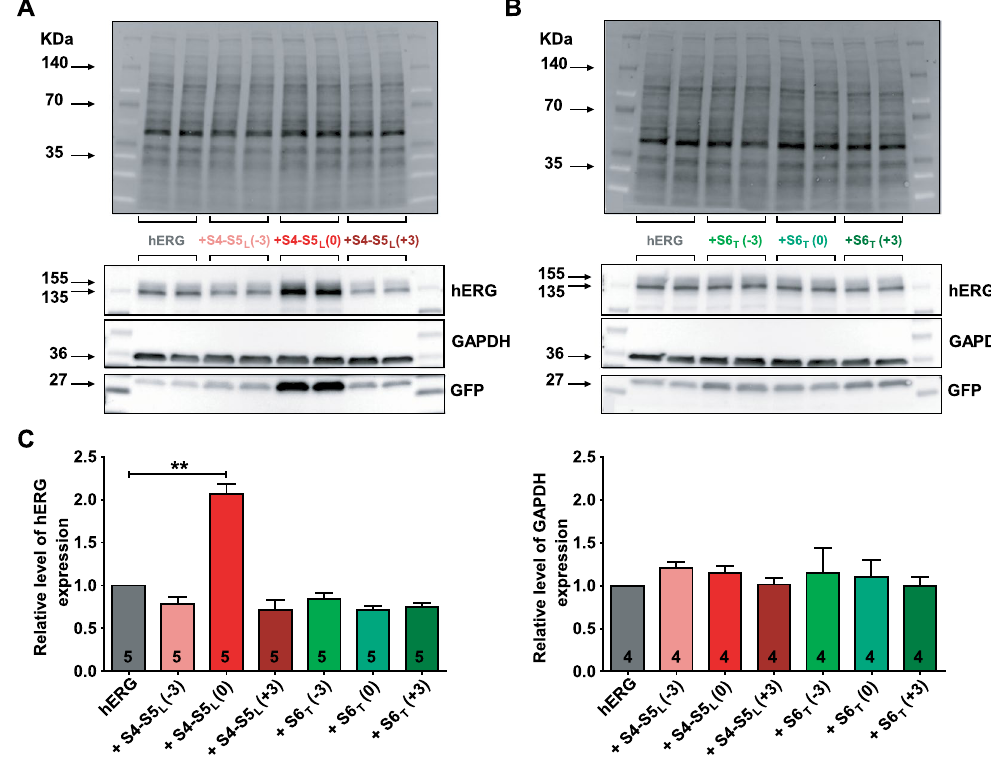
Figure 3. S4-S5 L (0) peptide increases hERG channel expression. (A,B) western blot analysis of hERG protein expression in COS-7 cell lysates in the absence or presence of S4-S5 L peptides ( A ) or S6 T peptides ( B ). Top: stain-free image of total proteins. Bottom: western blot images of hERG, GAPDH, and GFP proteins. The three blots, realized on the same membrane, are cropped. Full-length blots of each tested protein are reported in Supplemental Fig. 1. ( C ) Histogram of normalized mean intensity of hERG (left) and GAPDH (right) bands in the absence and in the presence of various S4-S5 L or S6 T peptides. Band intensities are first normalized to the intensity of the corresponding stain-free membrane lane, and ratios are then normalized to control hERG condition. ** p < 0.01 versus control hERG, Mann-Whitney test realized on non-normalized